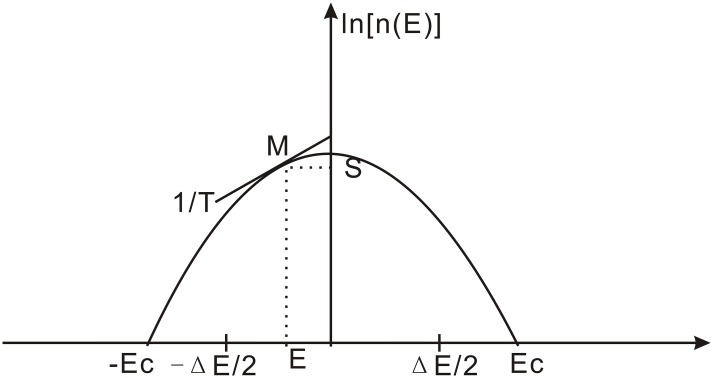
The entropy S(E) as a function of energy for the random energy model.The curve is entropy S(E) = ln[n(E)], where n(E) is the density of states with energy E from the spectrum, E
c is the corresponding energy of the trapping transition temperature T
c. As we see, the point M moves on the curve with the changes in the slope (1/T).